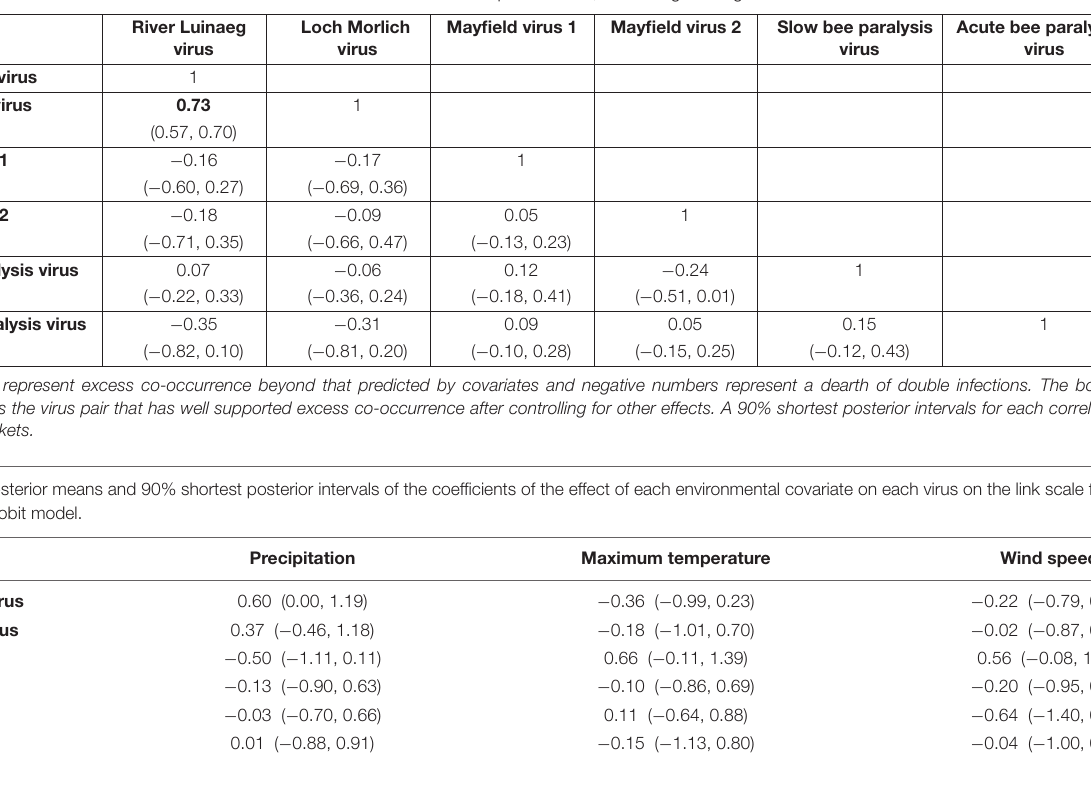
TABLE 1 | The posterior correlations of the errors of each virus from the multivariate probit model, measuring the degree of co-occurrence.